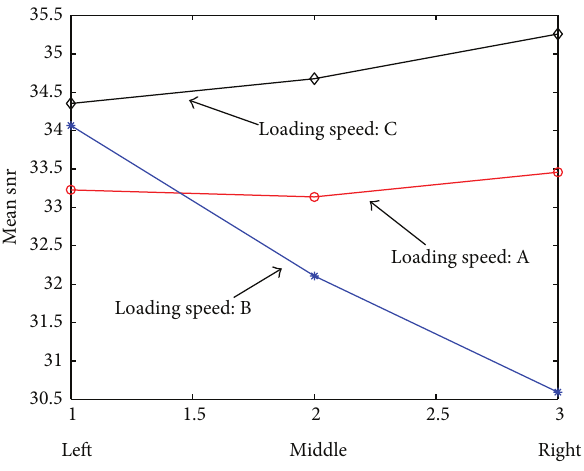
Figure 15: The variation plot of specimens under loading rates A, B,